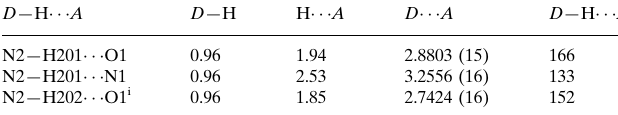
Hydrogen-bond geometry (A˚ , (cid:3)